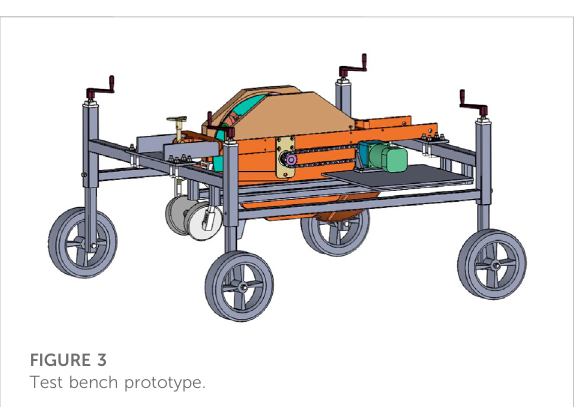
FIGURE 3 Test bench prototype.